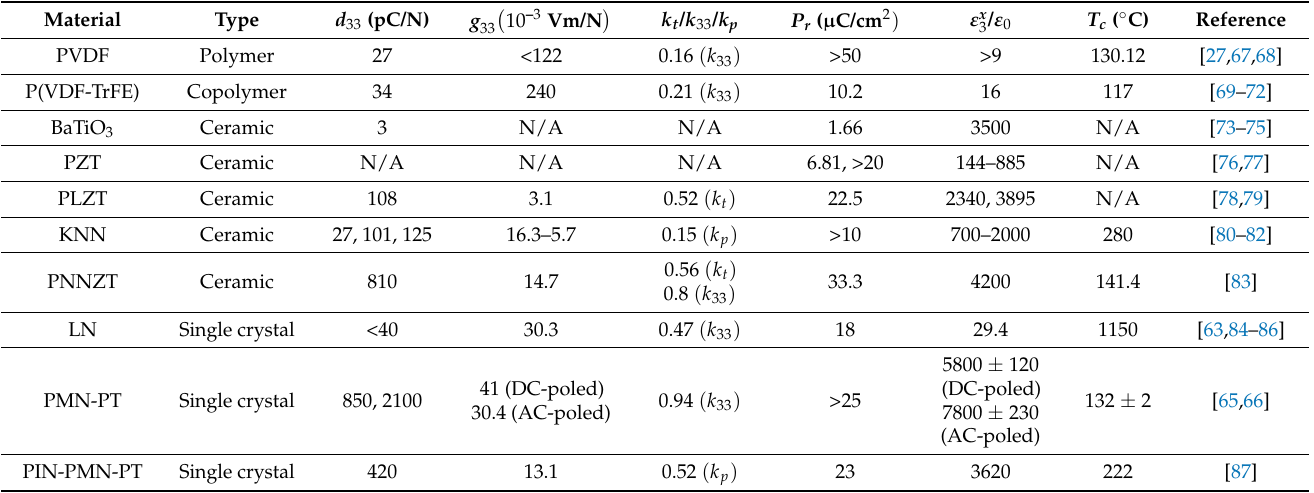
Table 1. Properties of representative transparent piezoelectric